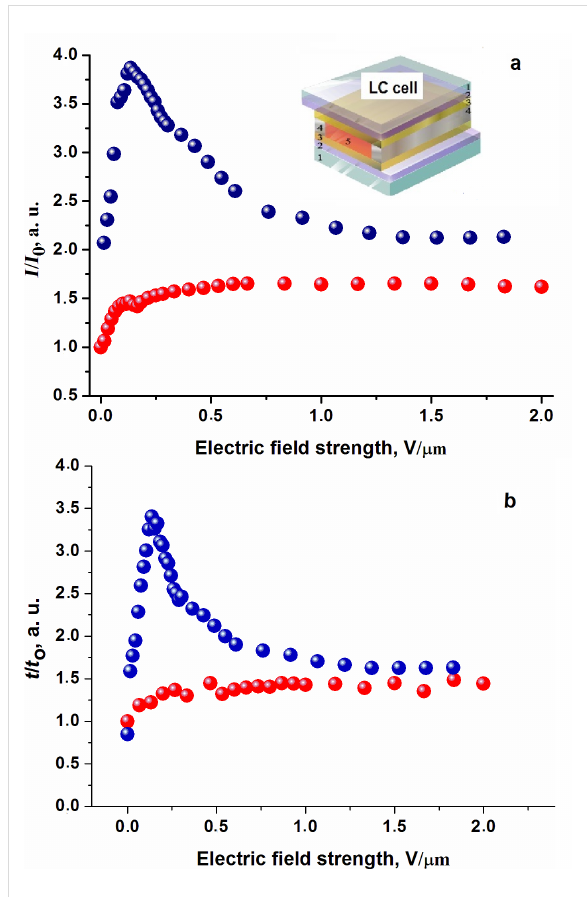
Figure 2: Relative intensities I / I 0 (a) and decay times t / t 0 (b) of the QD photoluminescence as functions of the electric field strength applied to LC cells with a planar (blue circles) and vertical (red circles) alignment. The insert shows the structure of a LC cell: 1 - quartz substrates, 2 - ITO electrode, 3 - orienting layer, 4 - spacers, 5 - liquid crystal